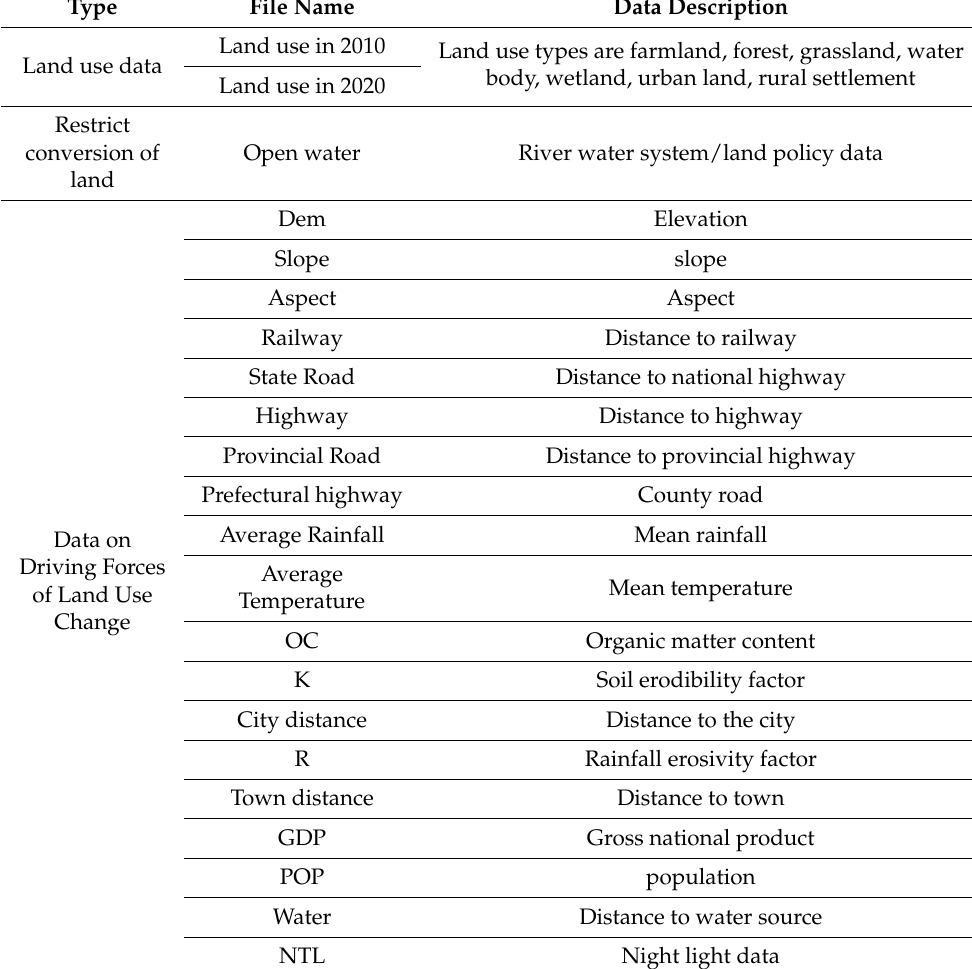
Table 3. Driving factor description